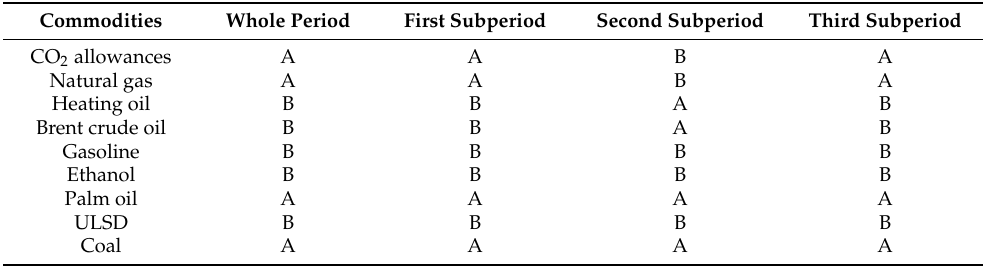
Table 1. Groups of commodities with respect to similarity of time series of their prices to the COVID-19 daily cases.